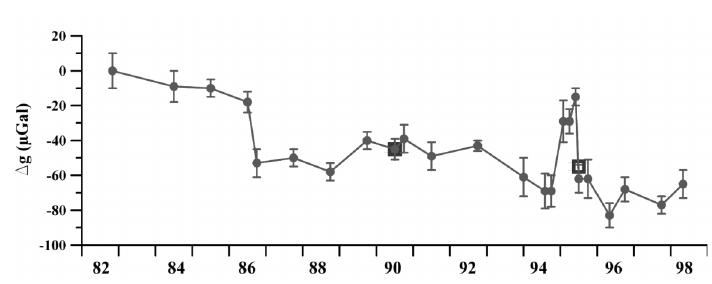
Fig. 7. Record of repeated relative (circle) and absolute (square) gravity measurements at Vulcano.